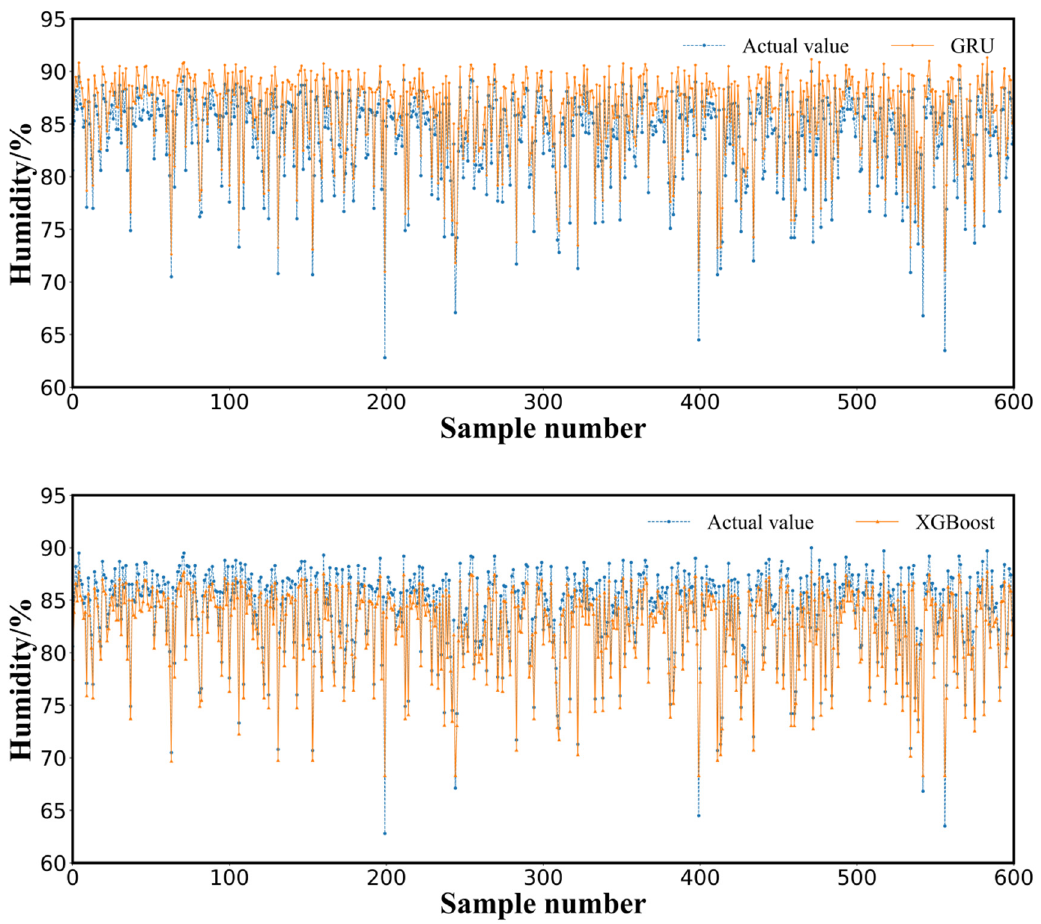
Figure 4. Measured versus computed humidity (validation level).